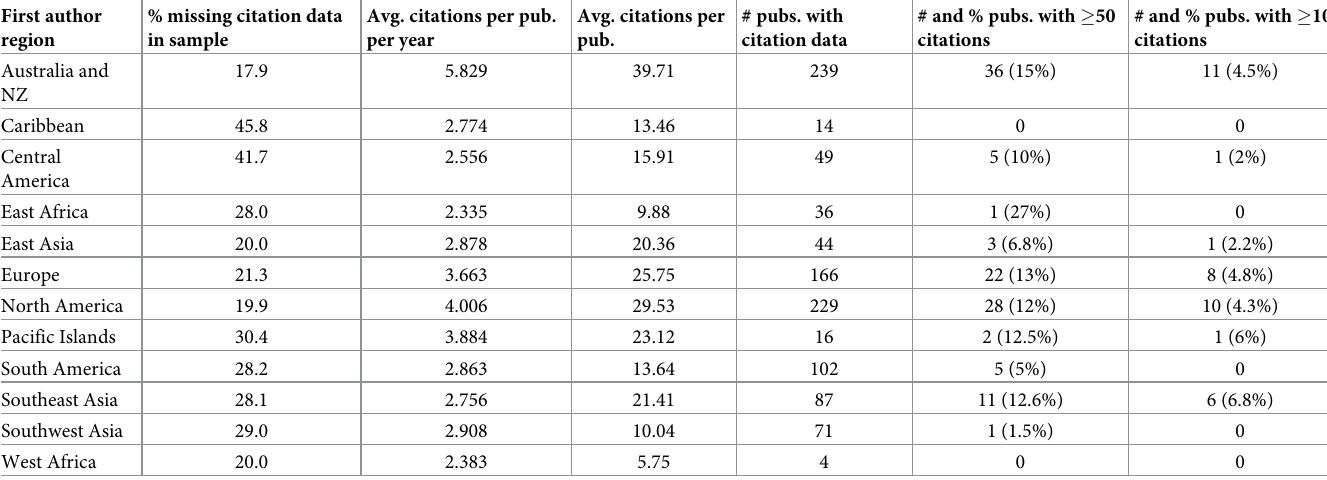
Table 5. Publication citation data by